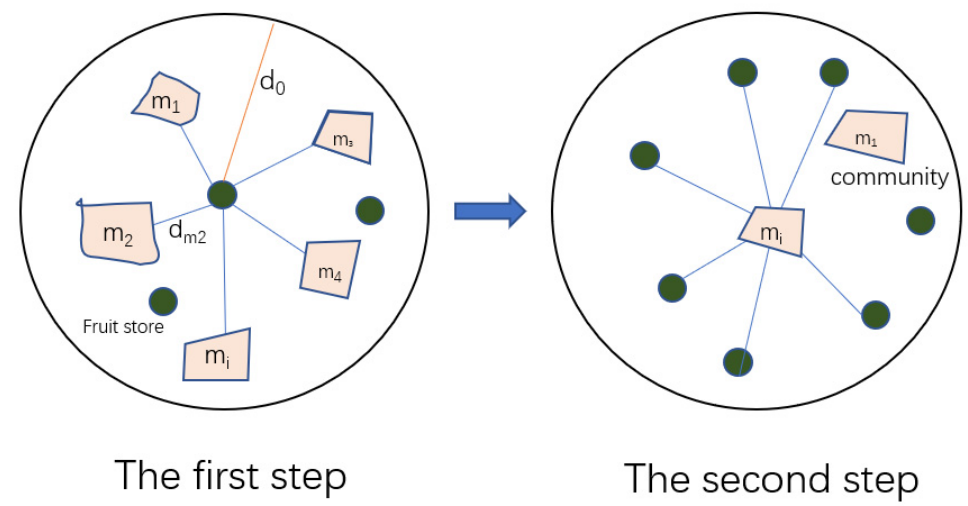
Figure 7. Conceptual description of the two-step mobile search method (E2SFCA).